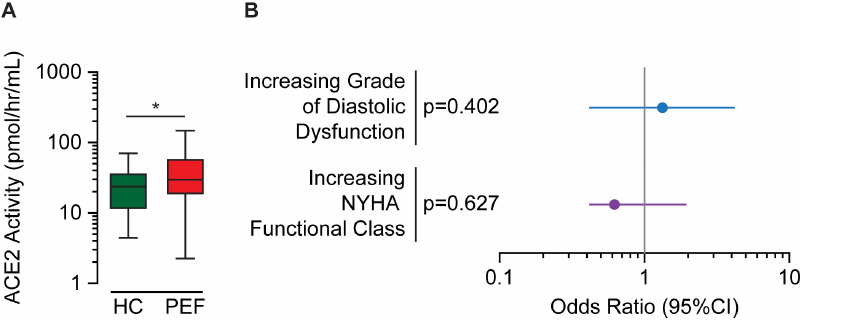
Figure 3. Angiotensin-converting enzyme 2 (ACE2) activity in HFPEF, and comparison with disease parameters. Box and whisker plots compare the distribution of plasma ACE2 activity in healthy control (HC) and HFPEF (PEF) (A). Forest plots show odds ratio and 95% confidence interval (95%CI) for ACE2 as predictor of increasing grade of diastolic dysfunction or NYHA class in HFPEF (B). * P , 0.05 for Mann Whitney U test.